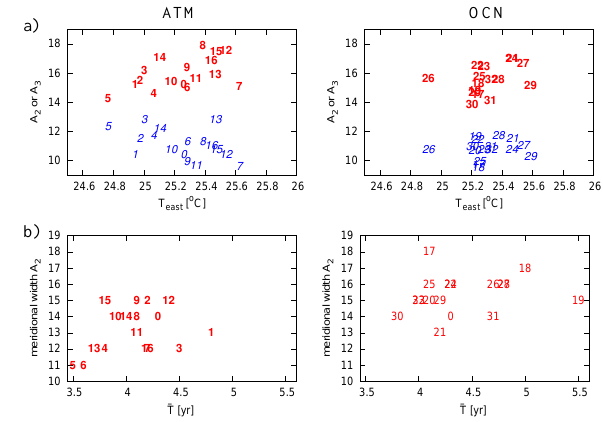
Fig. 6. (a) Statistical atmosphere box 2 and 3 in [10 − 3 Nm − 2 K − 1 ] vs SST for all members. Box 1 is not shown as this box shows no correlation with T east at all. Red are the western mean values, blue the eastern ones. The left column shows the ATM ensemble, the right column shows the OCN ensemble. (b) Meridional width of the response of wind stress to SST [degrees] in the central Pacific versus the mean period [years].